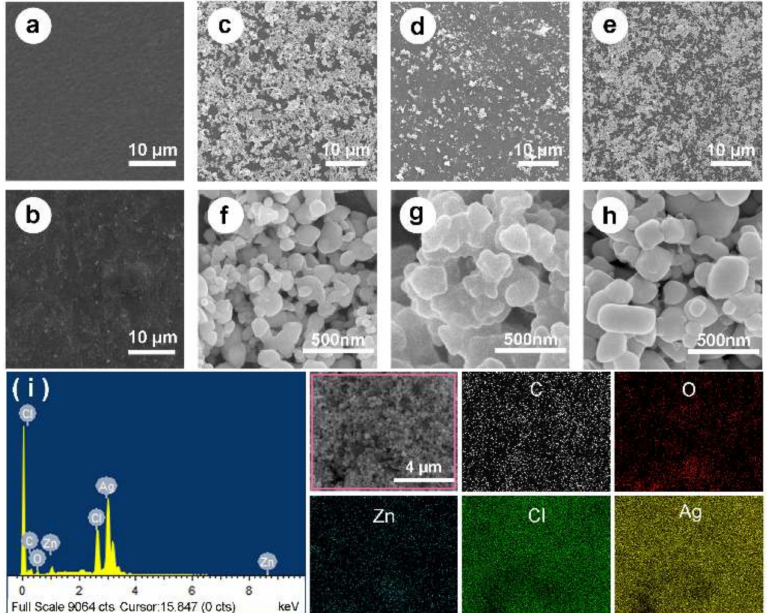
Figure 2. SEM and EDX. ( a – h ) The morphologies of different films are characterized by SEM. ( a ), M; ( b ), MP; ( c – e ), MPZ, MPA, and MPAZ, respectively; ( f – h ), higher magnification images of MPZ, MPA, and MPAZ, respectively; ( i ), EDX analysis of the elemental mapping of the selected region (indicated by a pink box) revealed the presence of zinc (Zn, blue), carbon (C, white), oxygen (O, red), silver (Ag, yellow) and chlorine (Cl, green), and the uniform distribution of ZnO and AgNPs on the surface of MPAZ